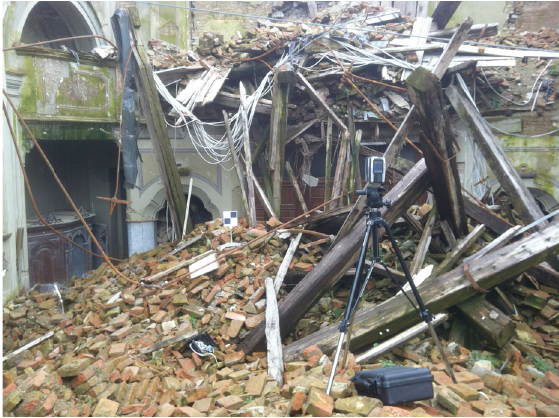
Figure 4: Faro Focus during the acquisition inside the